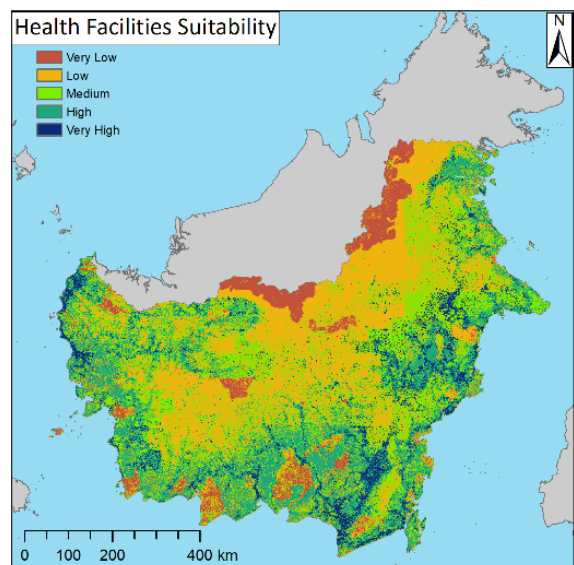
Figure 6 . Suitability of the area of construction of health